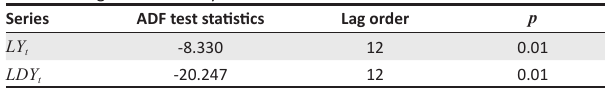
FIGURE 2: International tourist arrivals series. TABLE 2: Augmented Dickey-Fuller